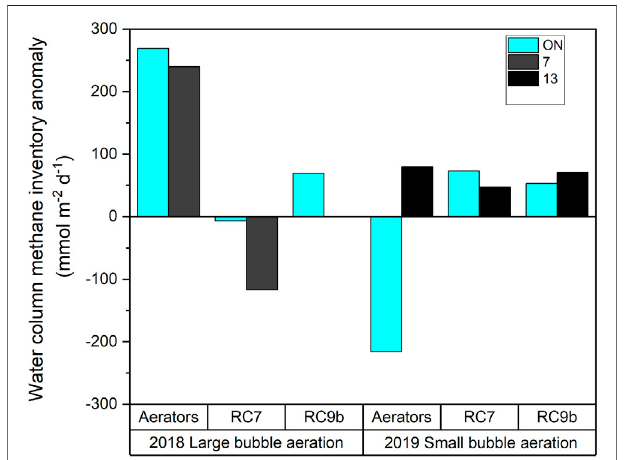
FIGURE 9 | Water column methane inventory anomaly assuming the sediments are the only source of methane to the water and the air-water interfaceistheonlysink.Apositivevaluemeansthattheremustbeasourceof methane to balance the source and sink, whereas the negative value means there must be a sink consuming methane.